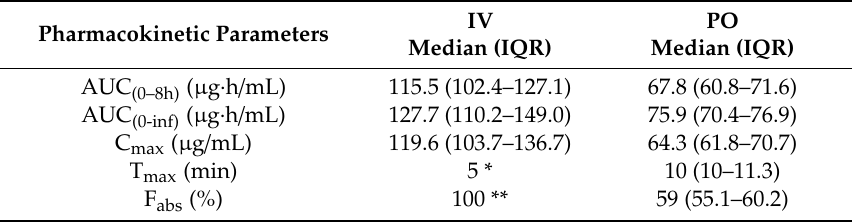
Table 4. Results of the pharmacokinetic analysis after IV administration of a CorA-solution and PO administration of the solid CorA-PVP-ASD formulation in BALB / c mice ( n =